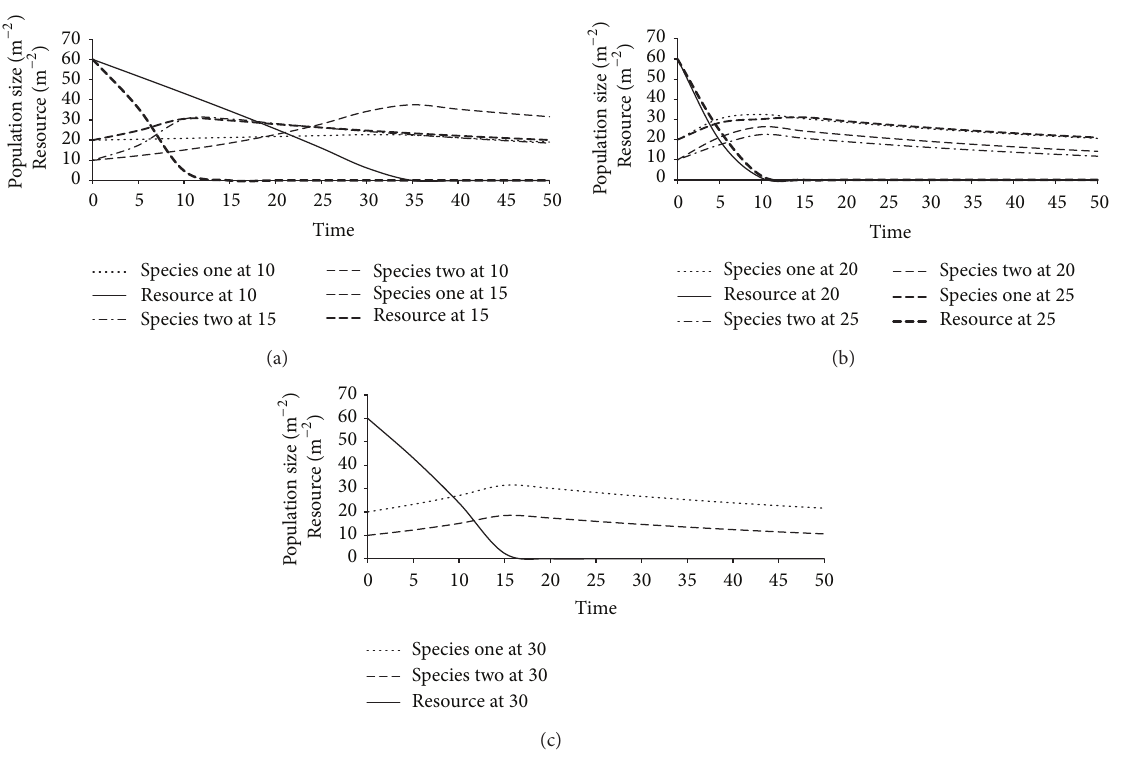
Figure 4: Behavior of the isoclines when the population size of species one is greater than species two; curves (a)–(c) show the behavior of population size for each species and the resource at temperatures: (a) 10 ∘ C and 15 ∘ C, (b) 20 ∘ C and 25 ∘ C, and (c) at 30 ∘ C, respectively.